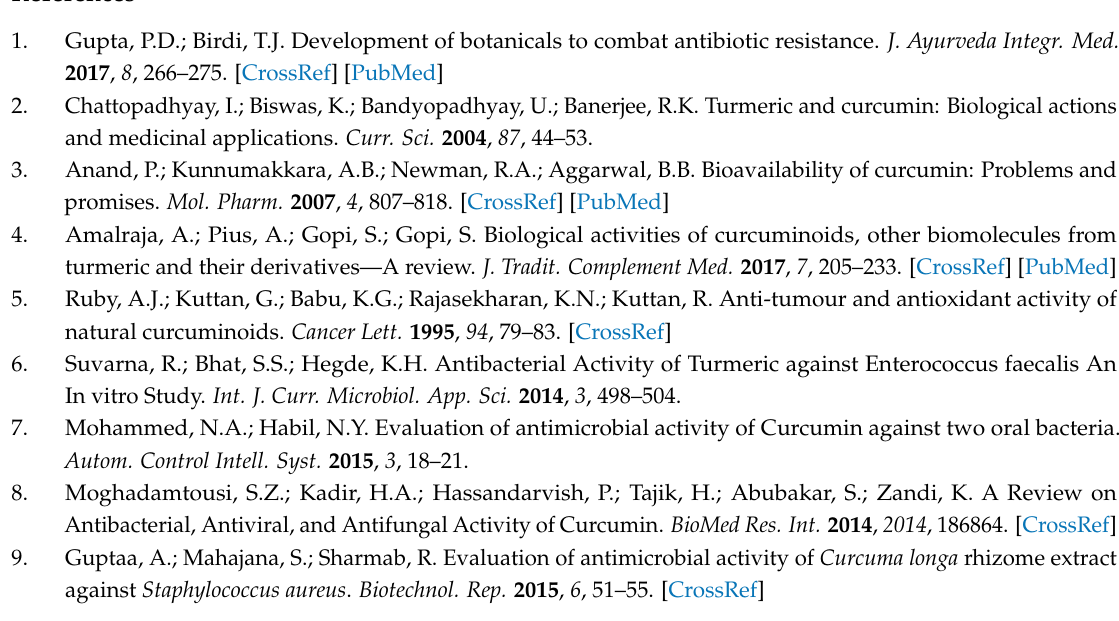
Figure S1 Purity of curcumin isolated by the centrifugal partition chromatography, Figure S2 EIC chromatograms of identified compounds present in the studied extracts of turmeric, Figure S3. Fragmentation patterns of curcuminoids isolated by centrifugal partition chromatography recorded in the CID collision energy of 20 V, Table S1. The identification of active zones on the TLC chromatograms by a TLC-MS interface coupled with a mass